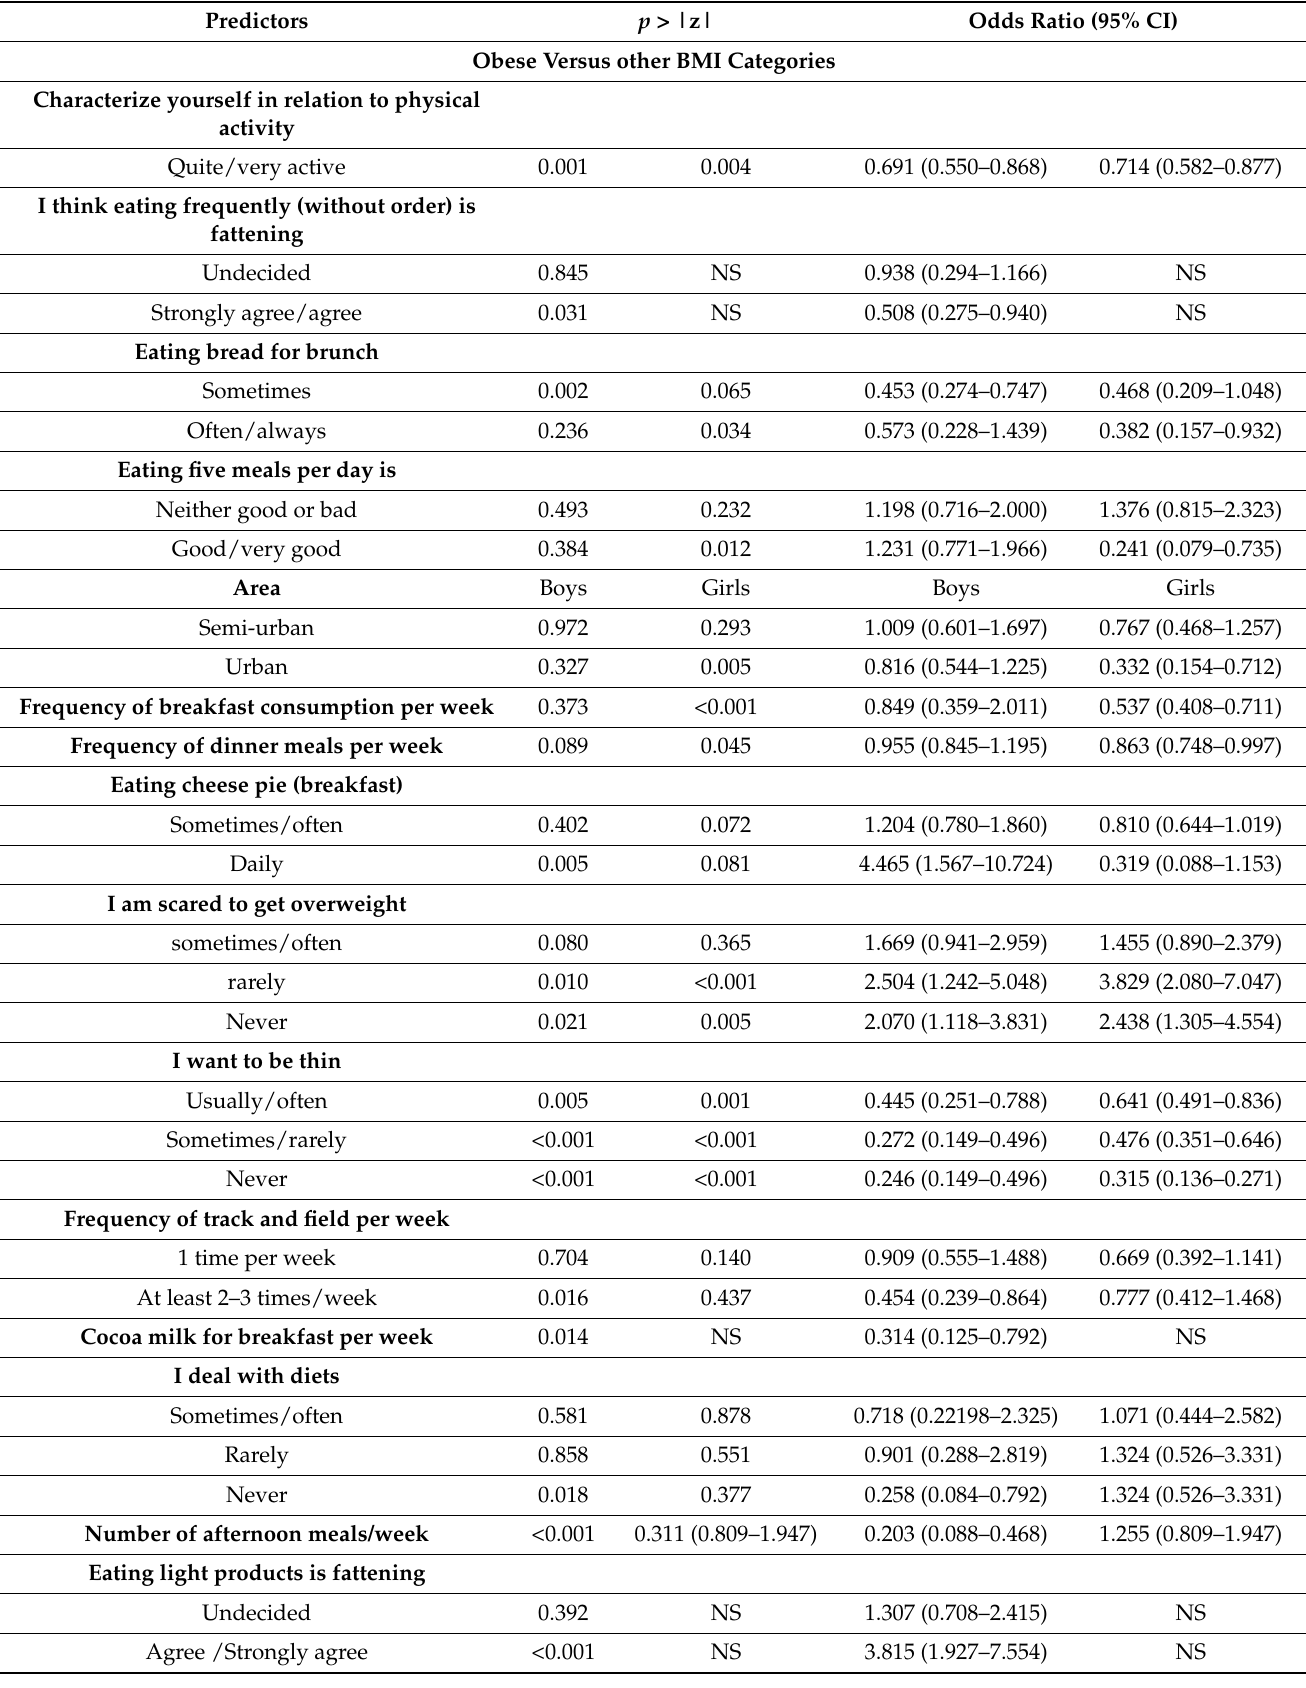
Table A7. Maximum likelihood estimates of Partial proportional odds model (obese versus other BMI